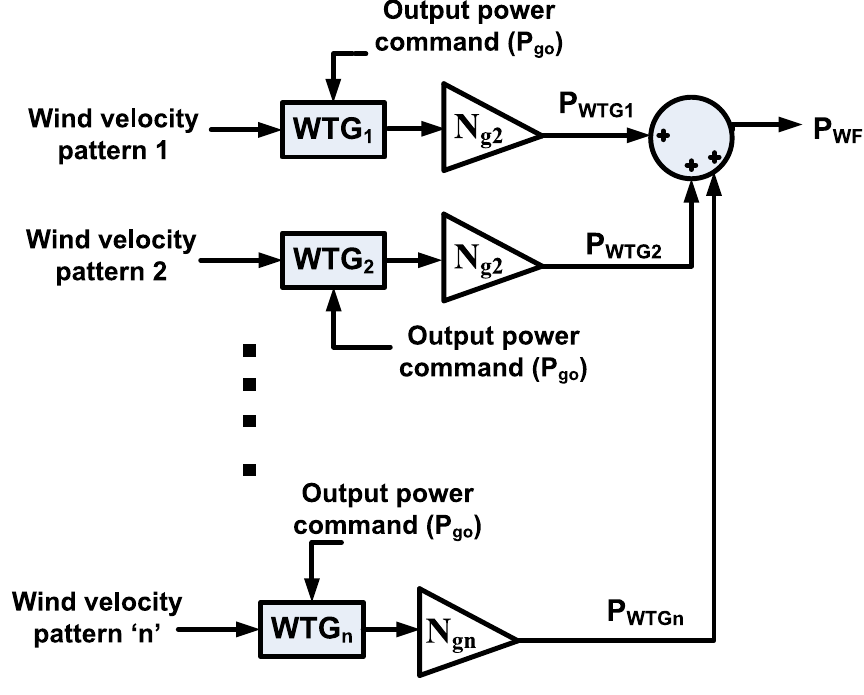
Fig. 6 Aggregated model of the wind